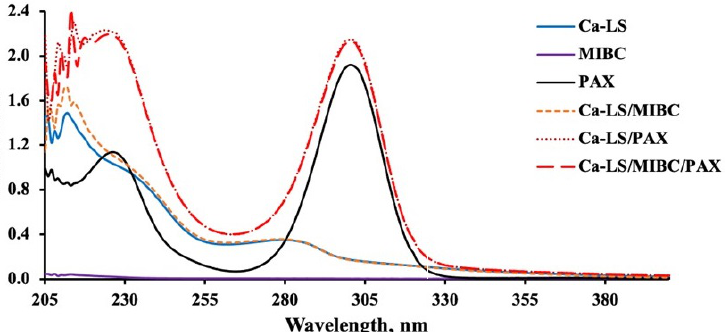
Figure 6. Absorbance spectra of Ca-LS (50 ppm), PAX (25 ppm) and MIBC (15 ppm), used in flotation without contacting the mineral in 0.01 M